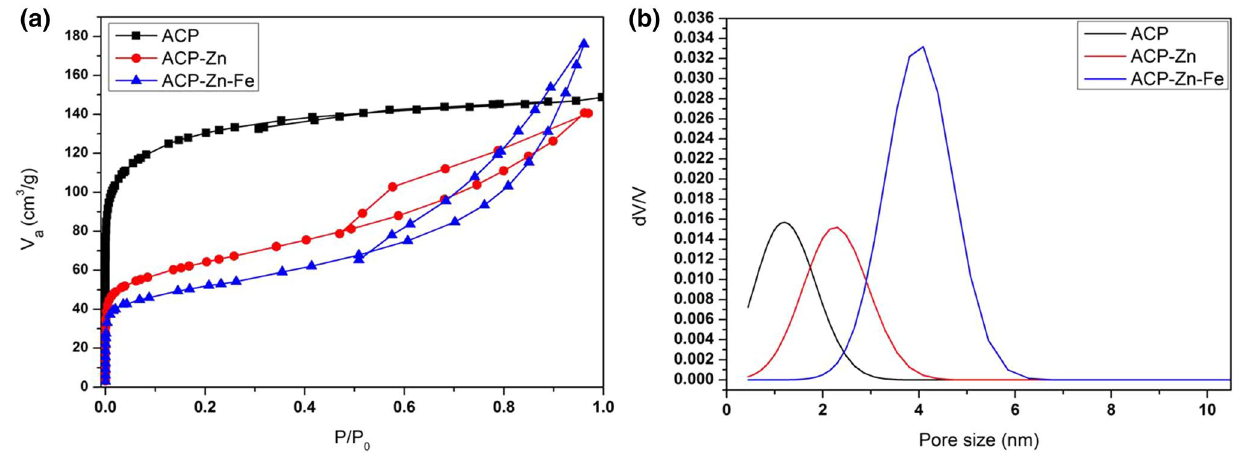
Fig. 2 a N 2 adsorption/desorption isotherms and b pore size distributions of the prepared